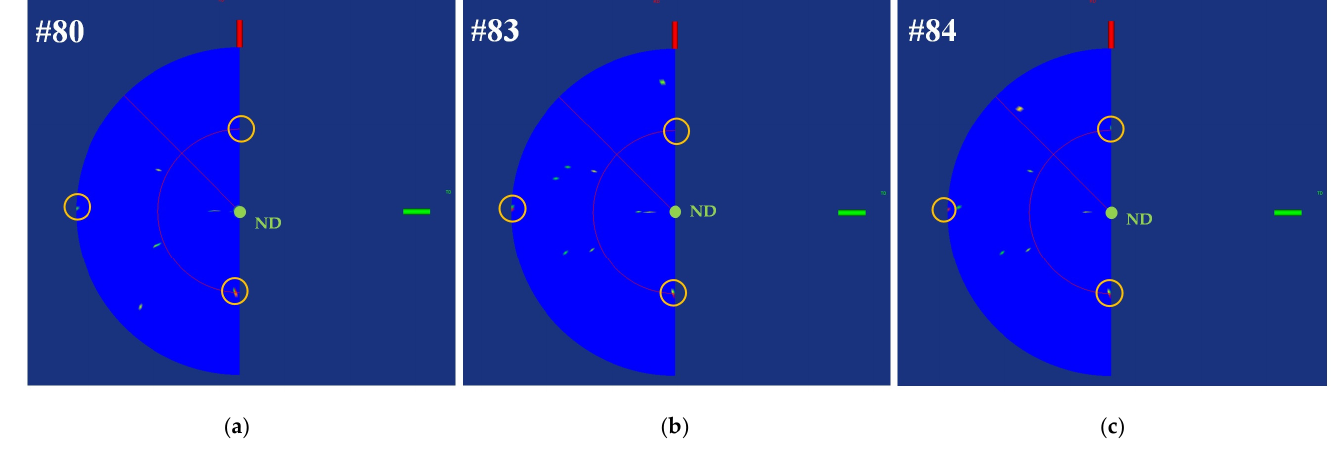
Figure 8. In-plane pole figures of (004) reflections for samples #80 ( a ), #83 ( b ), #84 ( c ). The ND direction presented (a normal to the drawing plane in the PF center) corresponds to a normal to a film surface. Yellow circles noted the provision of the main reflexes 400, 040, 004 in case of perfect structure (according to the theory).